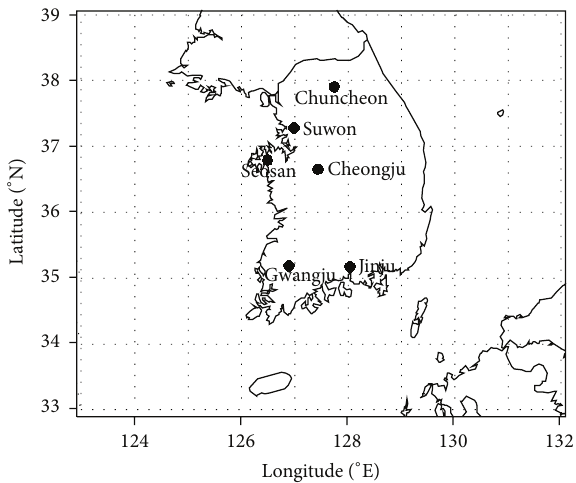
Figure 1: Location map of studysites used to analyze meteorological characteristics at frost